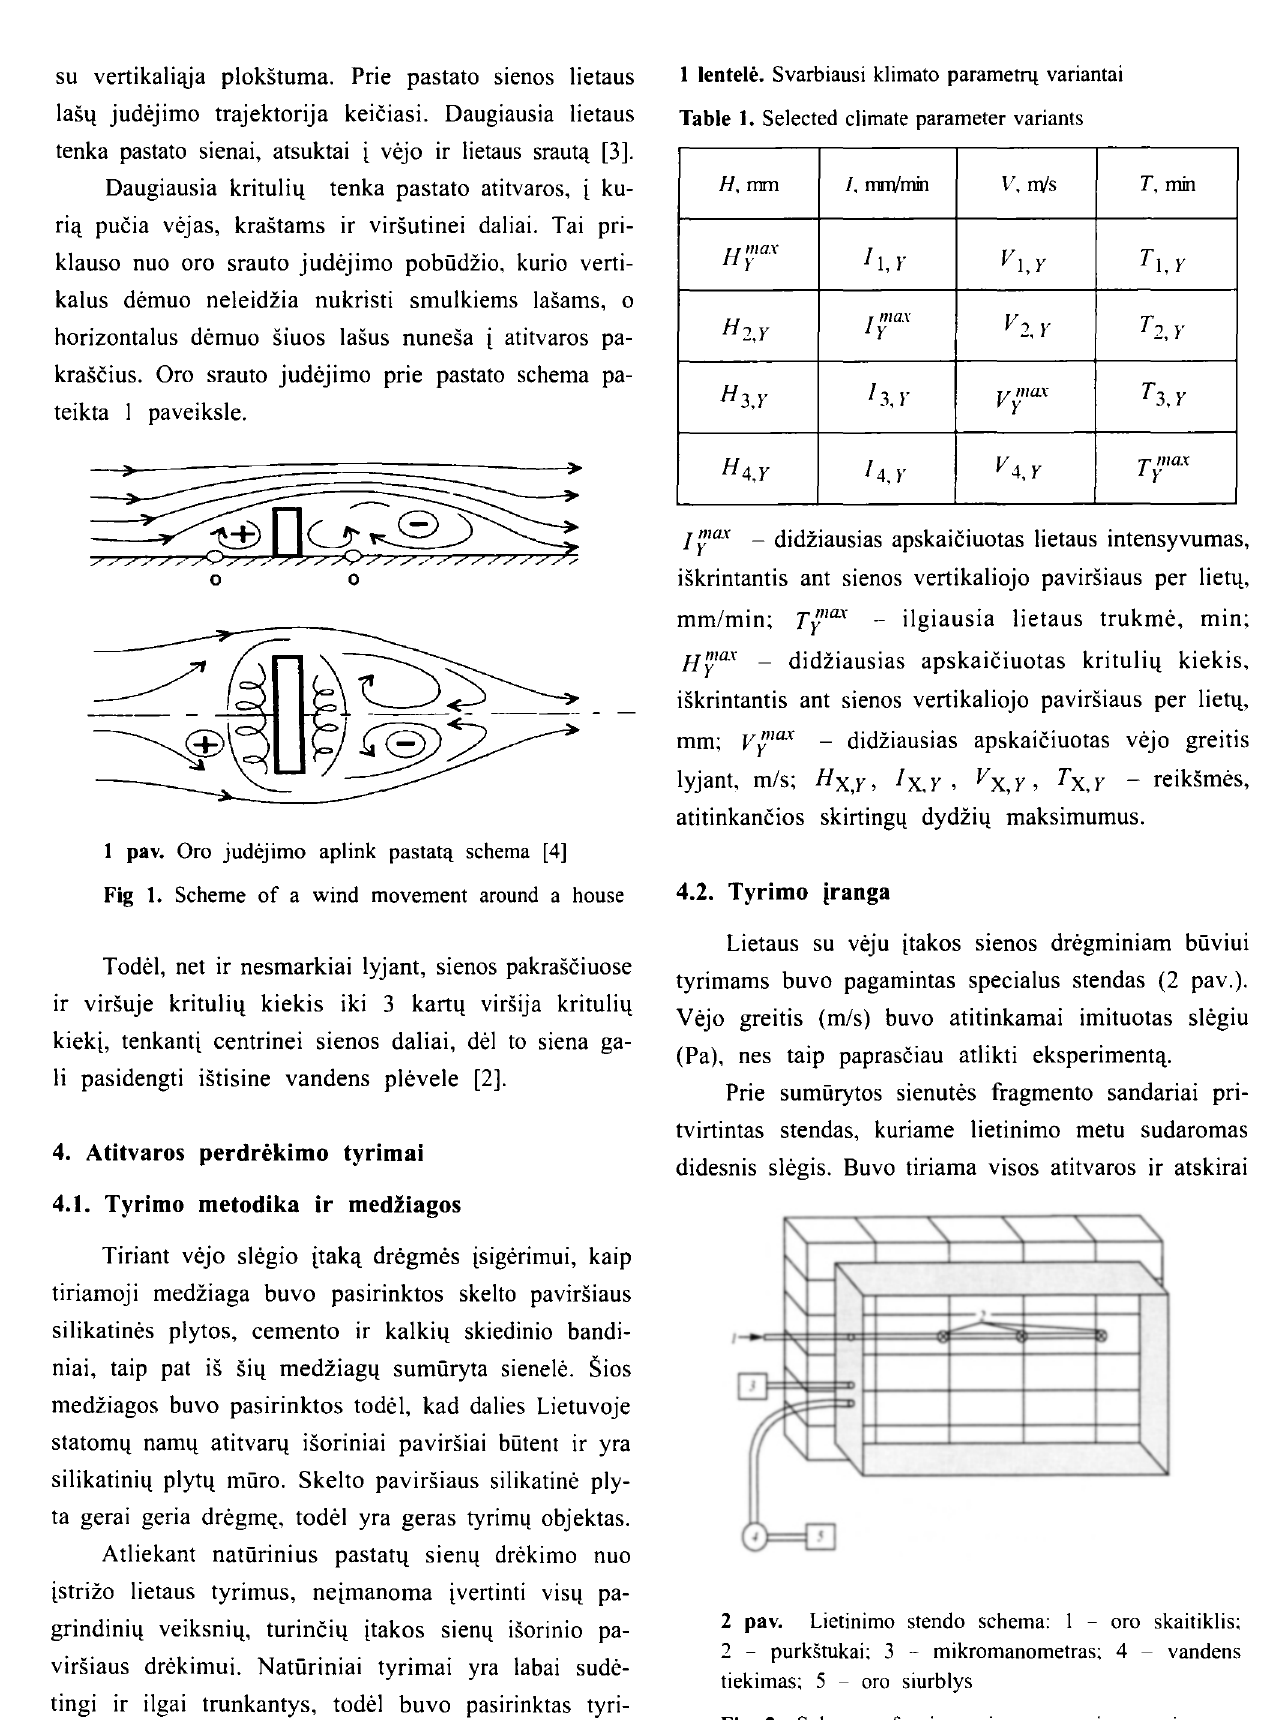
Fig 2. Scheme of rain resistance testing equipment: I - air meter; 2 - sprinklers; 3 - micromanometer; 4 - water feed; 5 - air